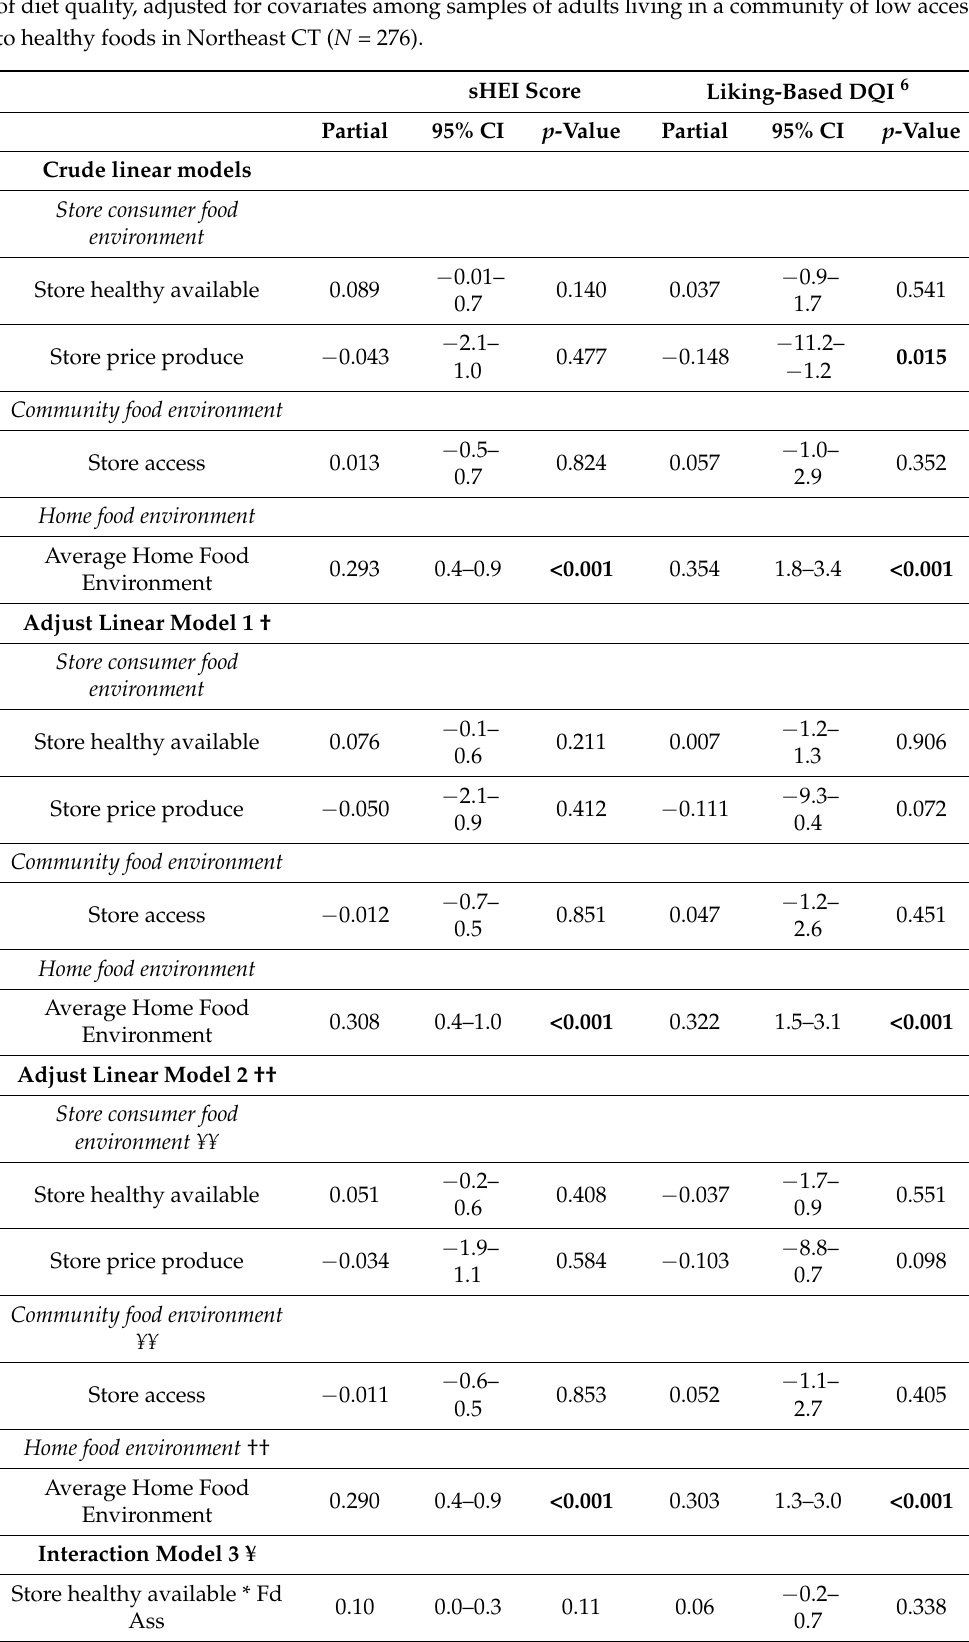
Table 5. Main and moderating effects of food assistance participation and ordering online on measures of diet quality, adjusted for covariates among samples of adults living in a community of low access to healthy foods in Northeast CT ( N =